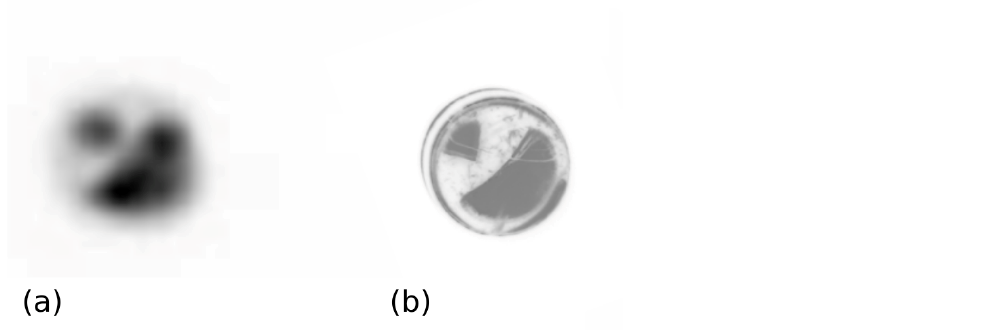
Figure 7. Inverted image of the central spot ( a ) and a macro photography of the emitter ( b ). The central spot resembles quite well the inner circuitry of the LED. The central spot images the LED, even though the recording was done from a distance of 13m.